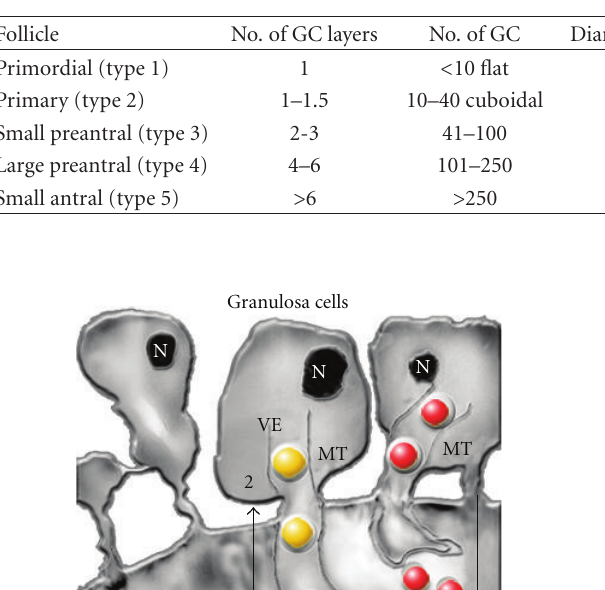
Table 2: Classification and characterization of bovine follicles [2, 27].